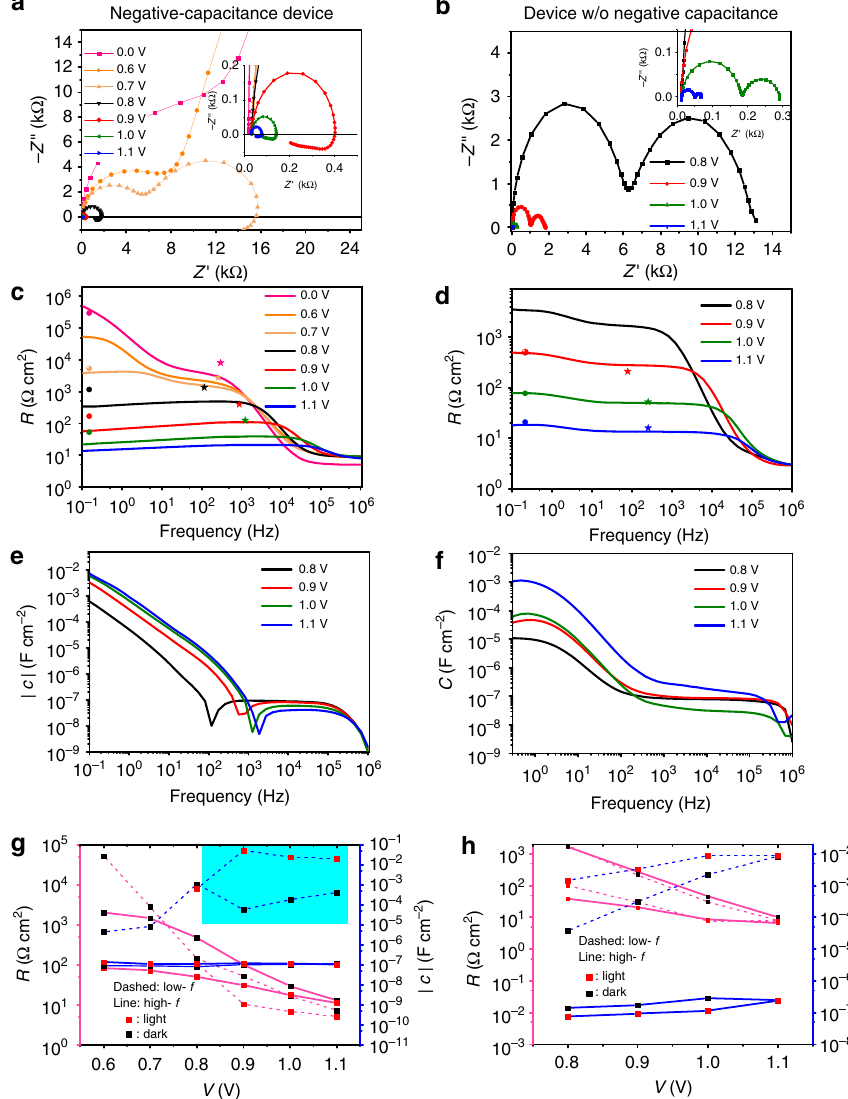
Fig. 2 EIS data as a function of applied voltage in the dark. Left: negative-capacitance device (0.02% Bi). Right: device without negative capacitance (0% Bi). a , b Nyquist plots showing approximately two semi-circles and the appearance of negative capacitance for voltages larger than 0.7 V. c , d Real part of impedance, visualizing the electrode series resistance for frequencies >10 5 Hz, a plateau at 1 kHz, and a higher (lower for negative C ) low- f resistance. The symbols indicate the differential resistance obtained from JV scans with 10 mV s − 1 (circles) and 10 V s − 1 (stars). e , f Apparent capacitance Im ð 1 = Z Þ ω , where in e C values for frequencies lower than the one where the dip occurs are negative. g , h Resistance and capacitance (negative values shaded) obtained by describing the EIS data measured in the dark and under 1 sun by two RC elements in series. R low f ∝ 1/ C low f is striking, in particular in